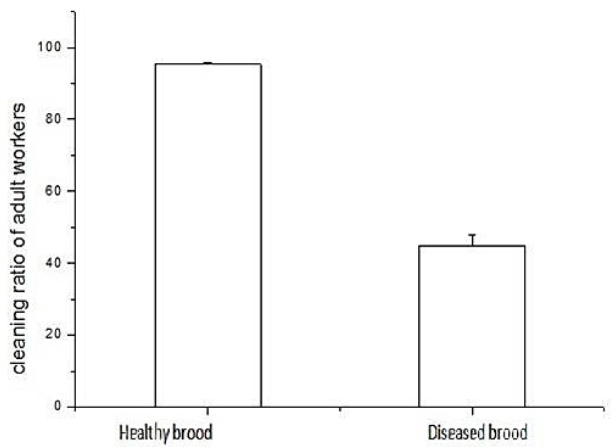
Fig 1 . Hygienic behavior of honey bee, Apis mellifera , adult workers in the healthy brood and diseased brood.